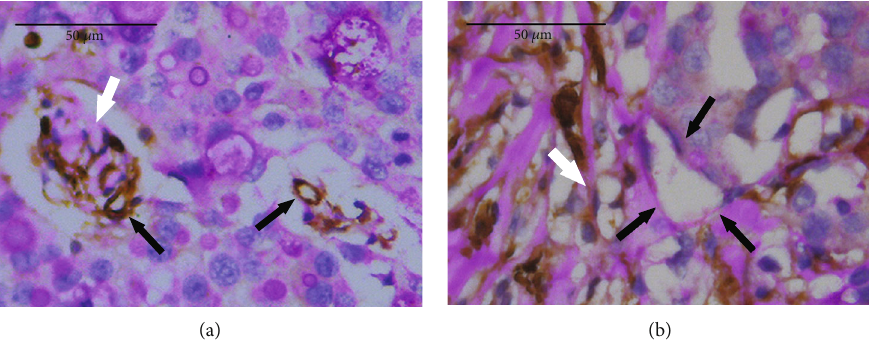
Figure 6: CD31-PAS double staining of tumor tissues after treatments ( × 400). (a) Brown granules (CD31-positive staining) were mainly observed in the endothelial cells under a light microscope, and PAS-positive staining was purple-red, showing coarse granular or fi ne mesh staining in the tumor cells and intercellular space. The IOD of CD31 and PAS was 286.53 and 281.79, respectively. The MV structures composed of endothelial cells with brown cytoplasm could be observed, showing di ff erent manifestations of endothelial cell cluster (white arrow) and vascular-like structure (black arrow). The IOD of CD31 and PAS of the MV structures was 183.56 and 5.06, respectively. (b) In a marginal area of the tumor, CD31-positive staining was noted in the endothelial cells, some tumor cells and intercellular space, and PAS-positive staining (purple-red) in the tumor cells and intercellular space showed coarse granular or fi ne mesh. The IOD of CD31 and PAS was 1601.93 and 1103.91, respectively. A mosaic blood vessel (black arrow) composed of endothelial cells and tumor cells was observed. In the structure, the endothelial cells were weakly positive for CD31, with the IOD of 9.26, and the cell matrix on the luminal surface showed PAS-positive staining, with the IOD of 31.99. White arrow: MV characterized by single endothelial